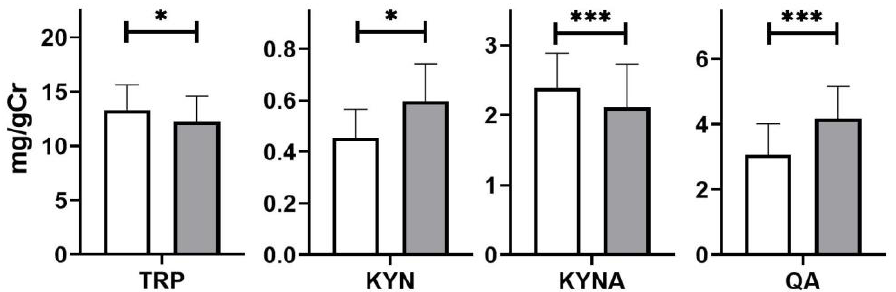
Figure 2. Urinary levels of tryptophan (TRP), kynurenine KYN, kynurenic acid (KYNA), and quino- linic acid (QA) in healthy subjects (white) and depressive patients with irritable bowel syndrome (blue). The differences between the groups were analyzed using the Mann-Whitney U test; n = 40 in both groups; * p < 0.05, *** p <